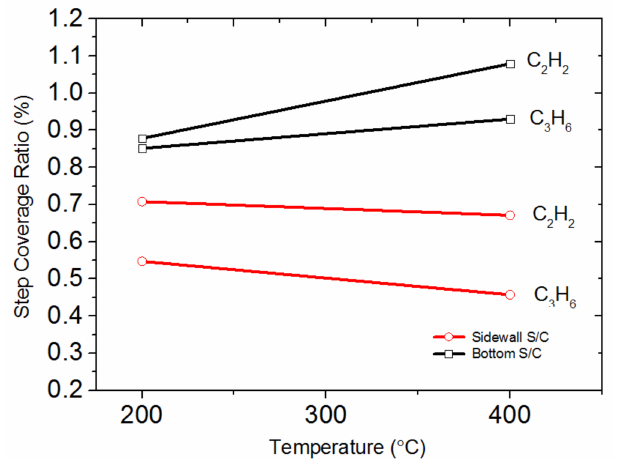
Figure 2. Results for the sidewall and bottom SC obtained using C 3 H 6 and C 2 H 2 carbon sources,